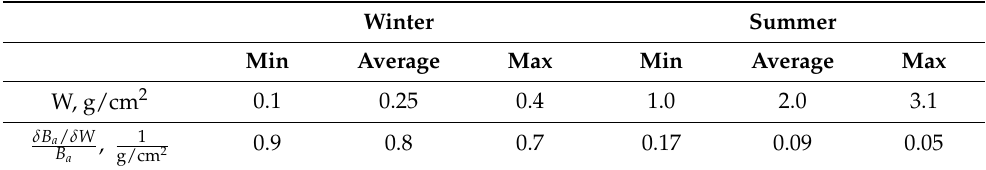
Table 4. Relative change of the flux Ba due to the change in W .